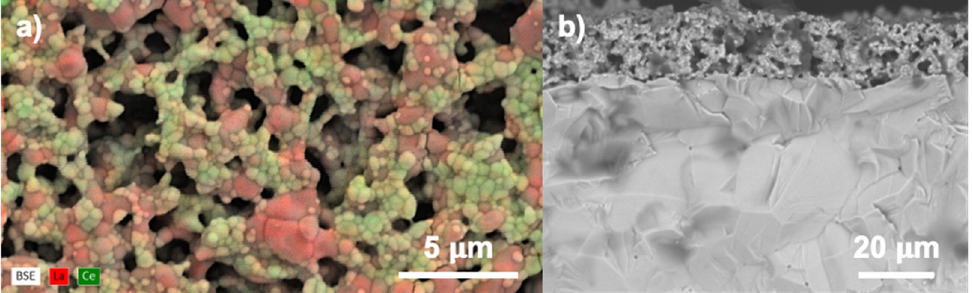
Figure 2. SEM analysis of the ( a ) top-view and ( b ) fracture cross-section of the LNO+BCY10 composite cathode.